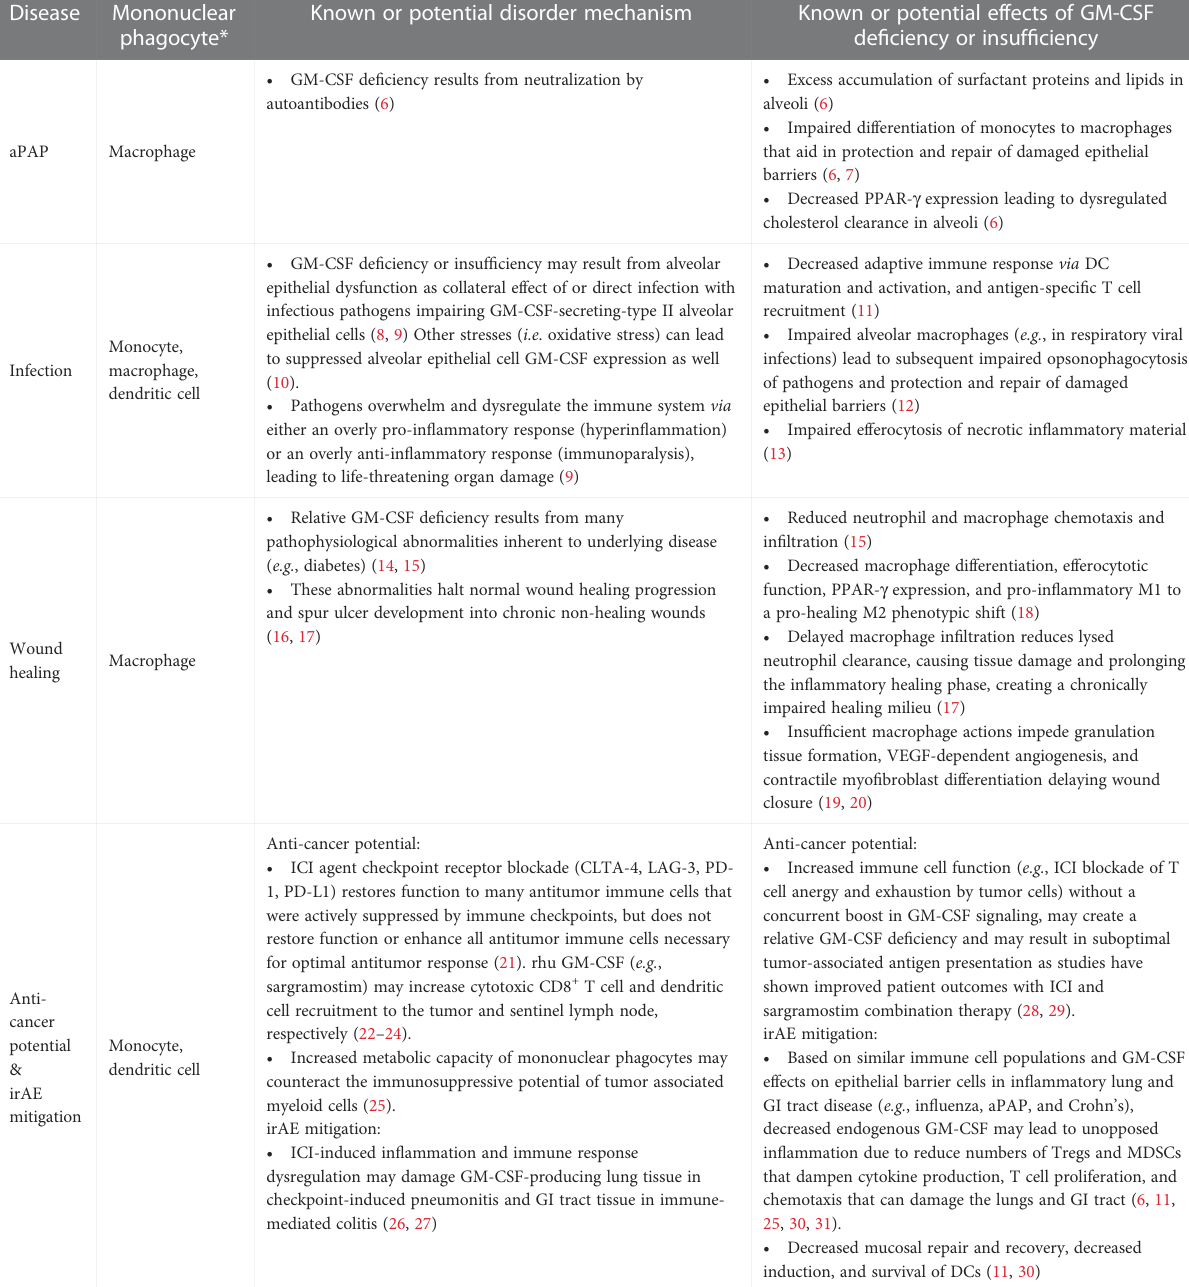
TABLE 1 Mechanisms and effects of GM-CSF de fi ciency or insuf fi ciency disorders.